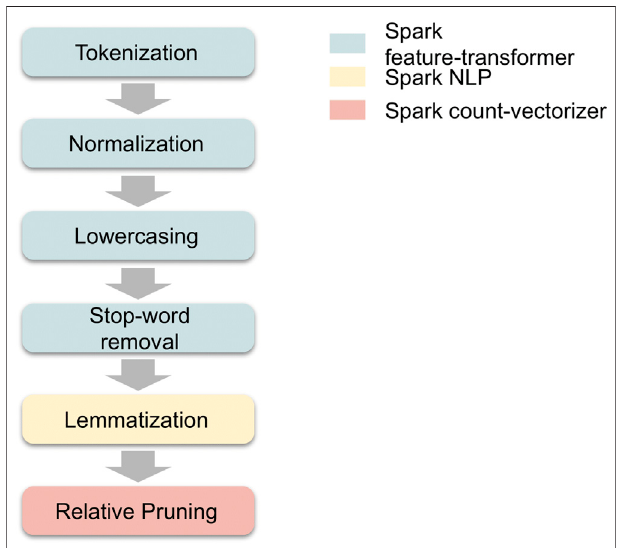
FIGURE 2 | Topic model preprocessing and transformation